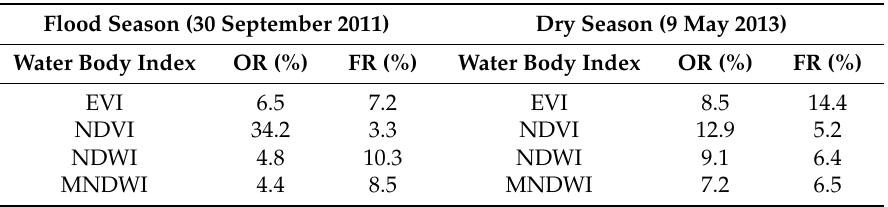
Table 2. Comparison of the Four Water Body Extraction